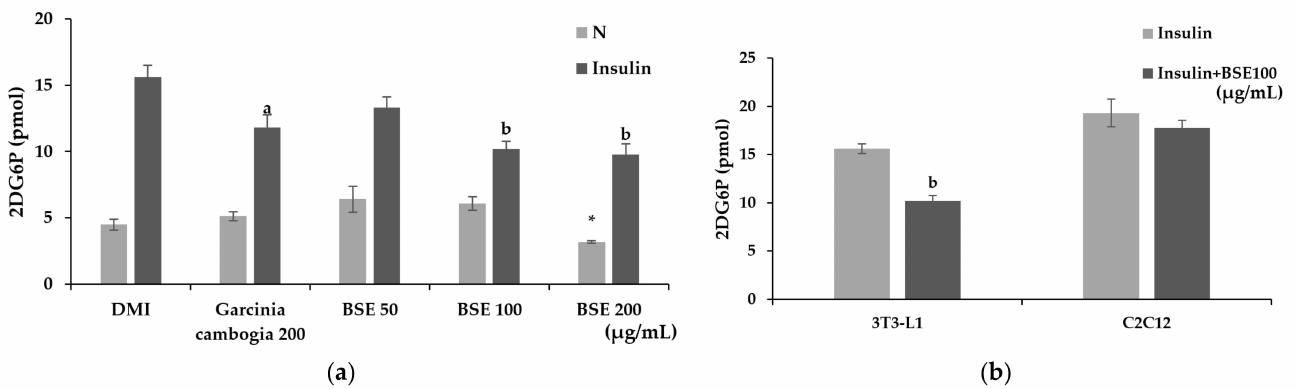
Figure 4. Changes in glucose uptake caused by hot-water barley sprout extract (BSE). ( a ) Changes in the glucose uptake of BSE with and without insulin stimulation in 3T3-L1 cells. ( b ) Comparison of changes in glucose uptake following insulin stimulation by 3T3-L1 and C2C12 cells. Statistical analysis was performed using one-way and two-way analysis of variance (ANOVA). * p < 0.05 compared with DMI group. a p < 0.05 and b p < 0.01 compared with the DMI + Insulin group. N: no substance treatment; DMI: 1 µ M dexamethasone, 0.5 mM 3-isobutyl-1-methylxanthine, and 1 µ g/mL of insulin; G: Garcinia